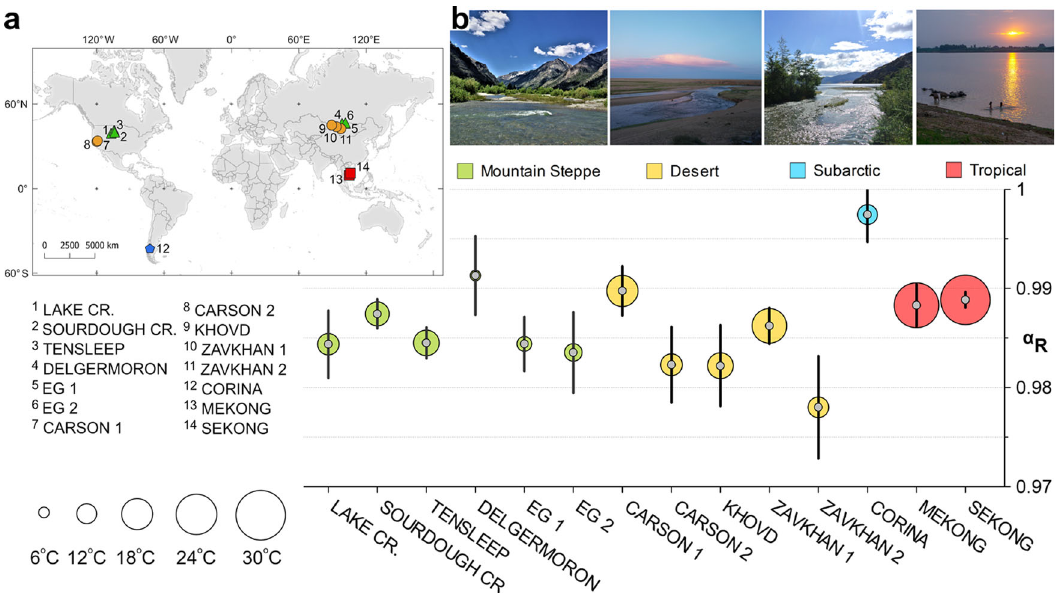
Fig. 1 Map of study sites of different biomes and isotopic fractionation factor ( α R ) values tested in the models. a Map using green triangles to note temperate river sites, yellow circles for desert sites, red squares for tropical sites, and a blue pentagon for the sub-arctic site. b Gray dots represent average measured α R values within each study site and black bars indicate ±1 SD. Modi fi ed fi gure from ref. 30 . Circle sizes are proportional to water temperature (as an average during the time of measurement) in each site. Pictures illustrate rivers' characteristic of each biome and show that our sites were mostly open canopy in all